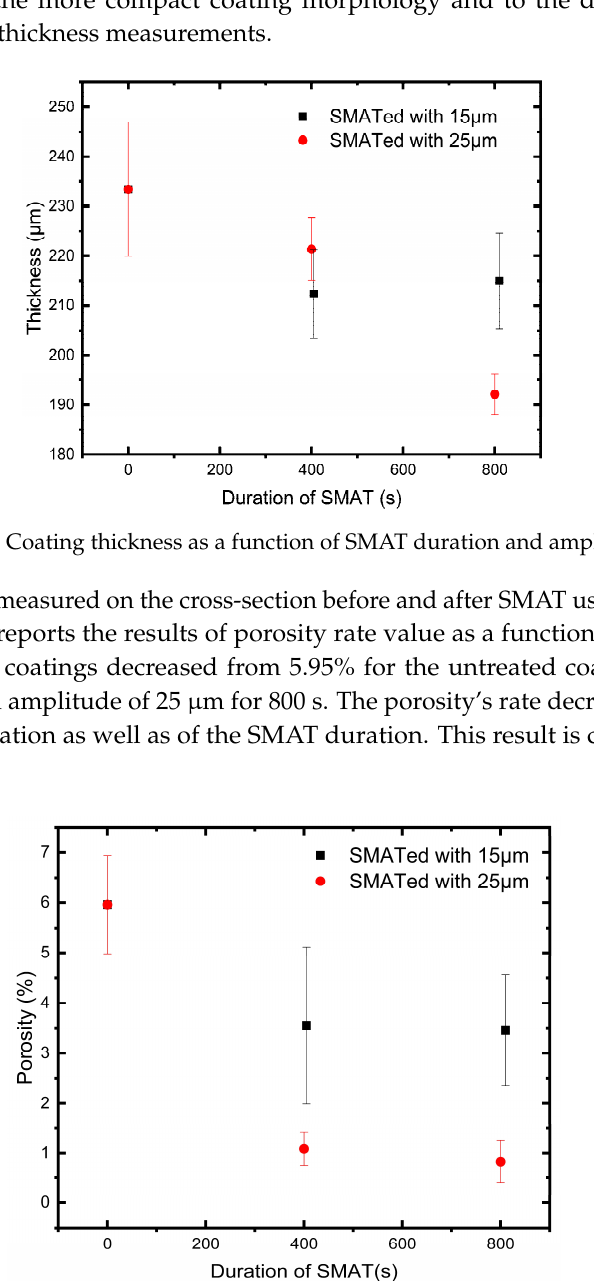
Figure 2. Cross-sectional morphology of 80Ni–20Cr coating: ( a ) Untreated Ni–Cr; ( b ) SMATed with